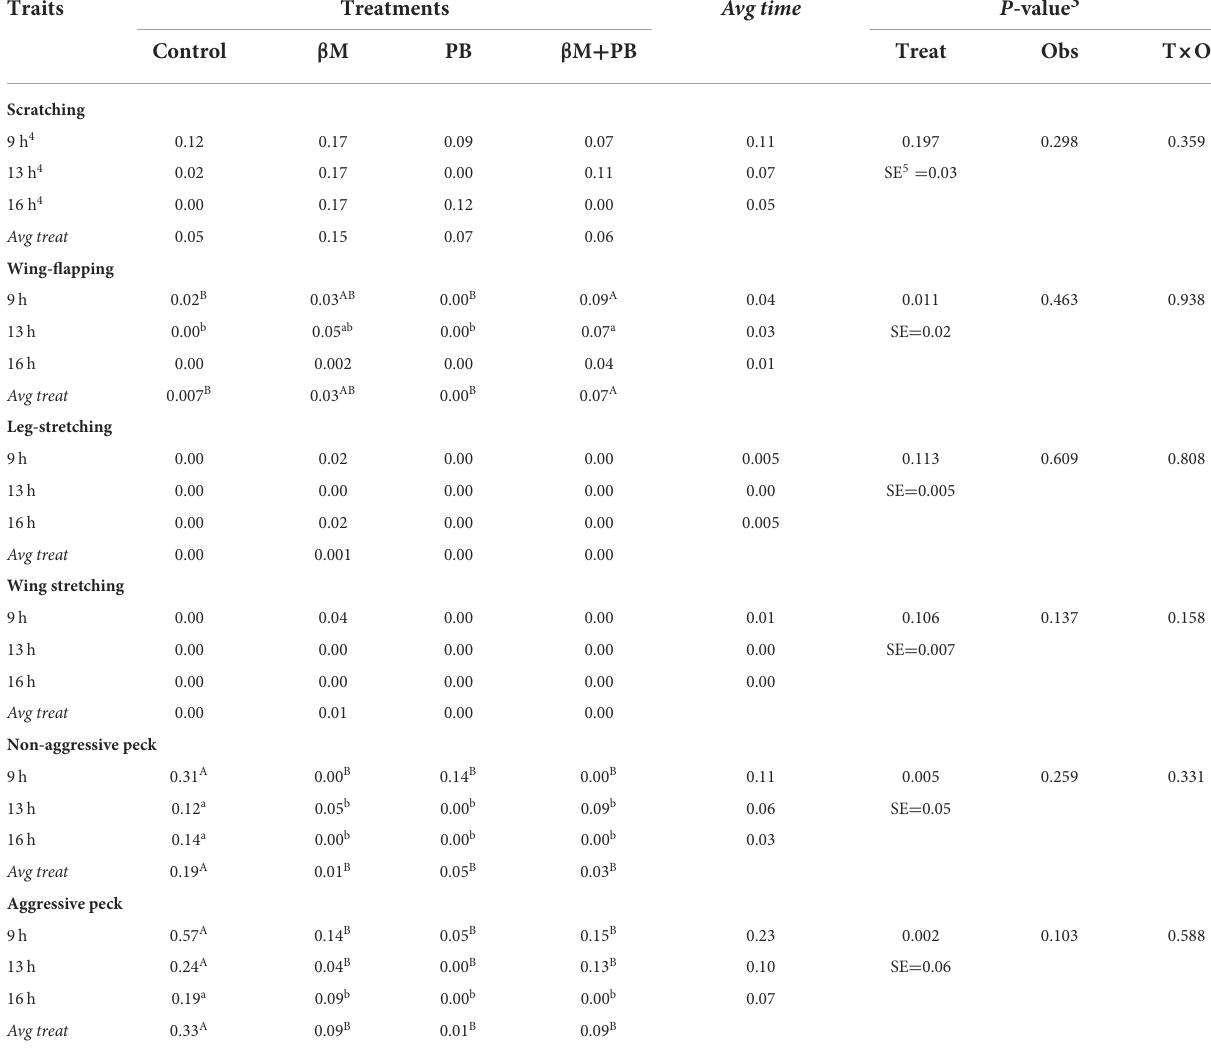
TABLE 4 Time expended (minutes/bird) 1 in other behaviors by laying hens fed beta-mannanase and/or probiotics 2 .